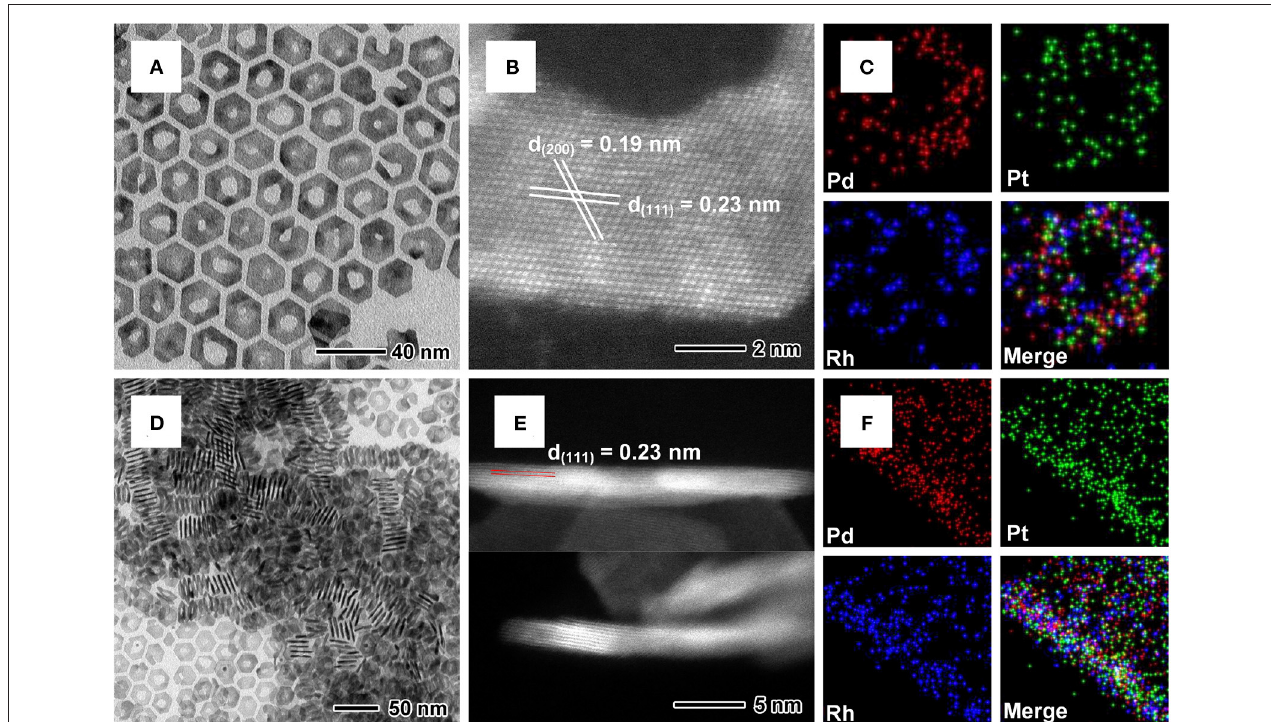
FIGURE 1 | (A) TEM, (B) atomic-resolution HAADF-STEM, (C) EDX mapping images of the planar Pd@PtRh nanorings. (D) TEM, (E) HAADF-STEM, (F) EDX mapping images of the vertically upstanding Pd@PtRh